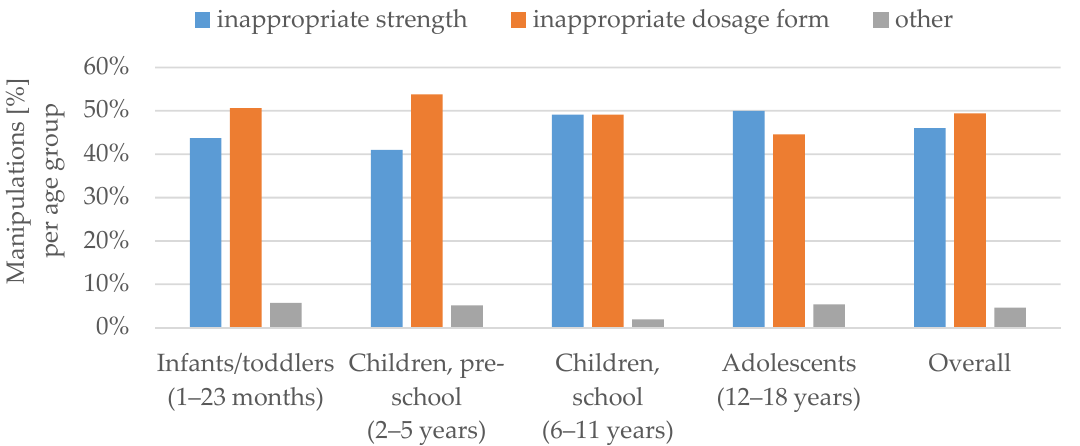
Figure 5. Root causes for manipulation (%) per age group.